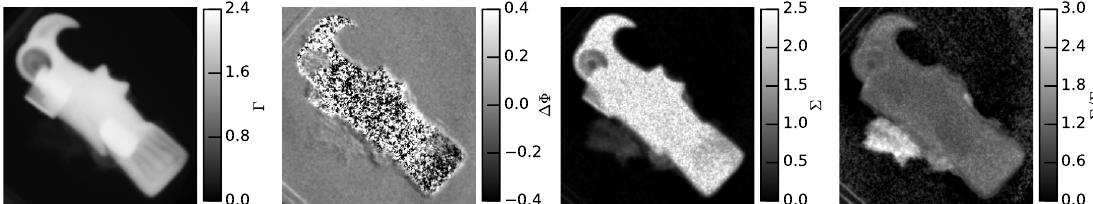
Figure 10. From left to right: Bird fibula shown in attenuation, differential phase, dark-field and normalised scatter image, acquired at 120kVp and 2mAs per phase-step.